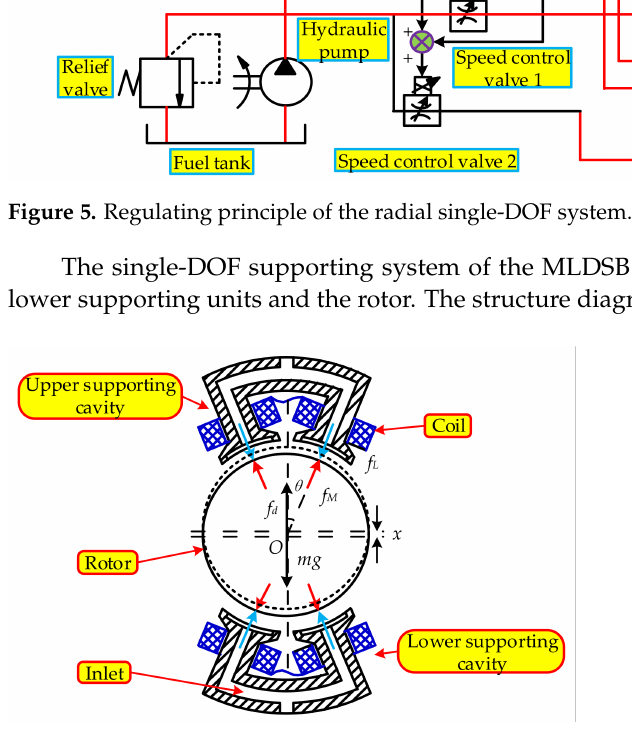
Figure 6. Structure diagram of the single-DOF